Question: Write a caption explaining this figure to a reader.
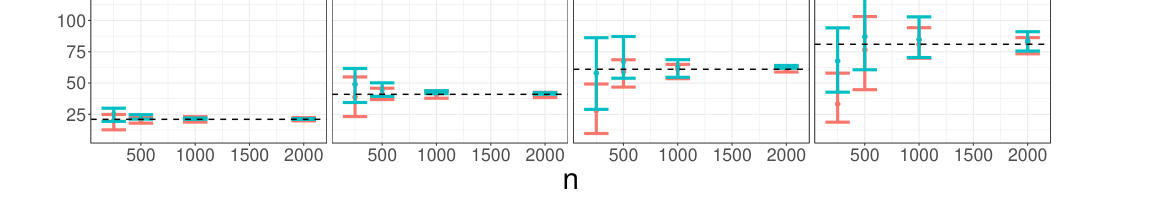
Answer: The average EDF and GDF values and their associated 2.5 and 97.5 quantiles versus sample size for different neural network architectures. The horizontal dashed line represents the number of parameters for each architecture.